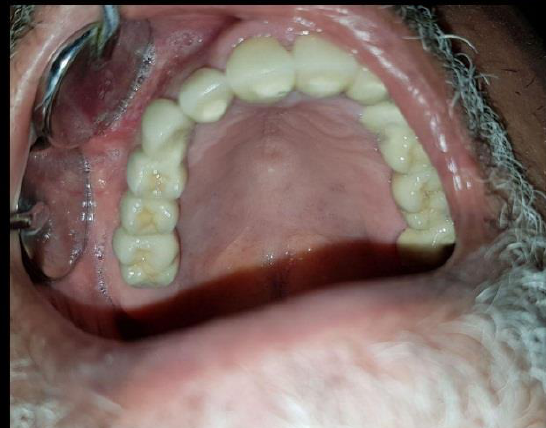
Figure 5: Installation of dental implant in its position.